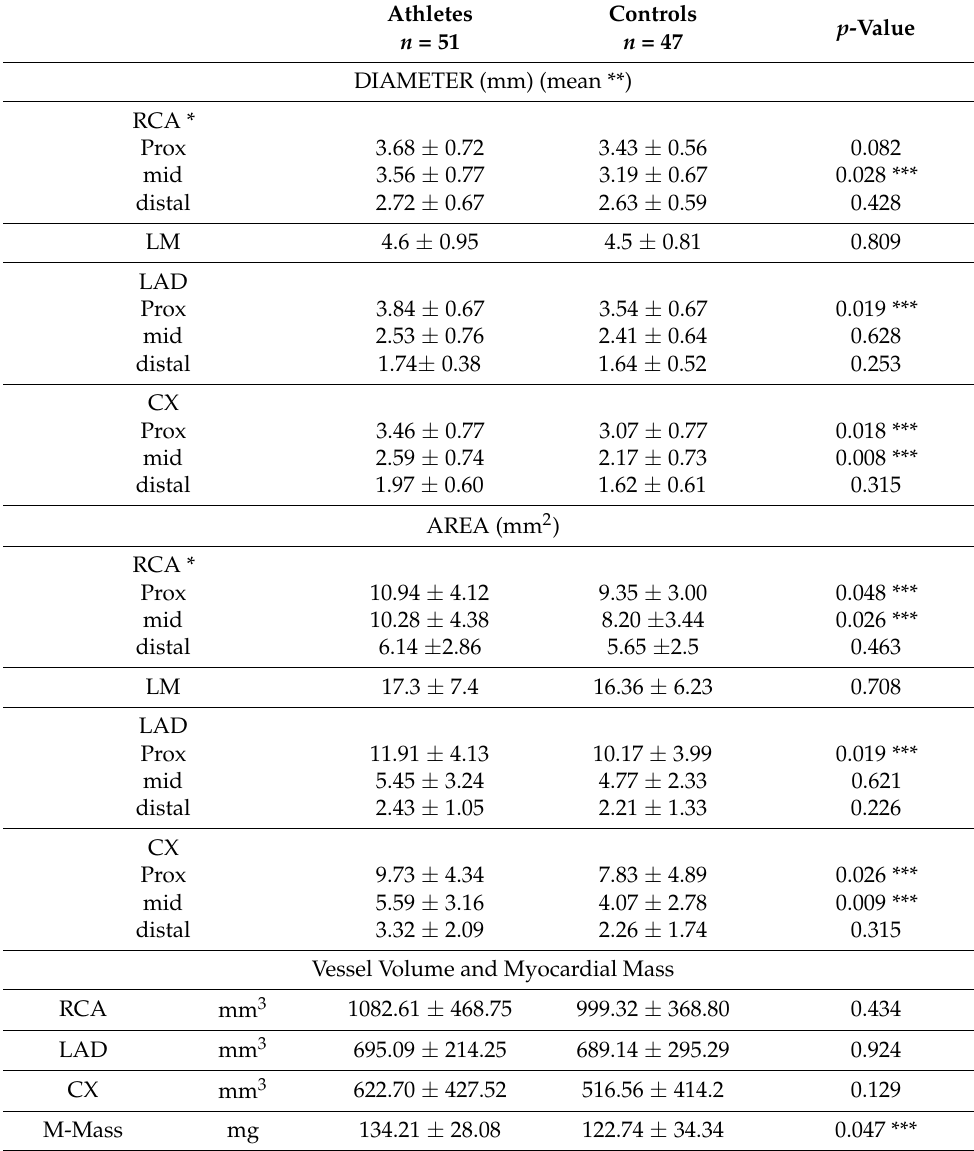
Table 2. Coronary artery size by CTA: athletes vs. controls ( n =